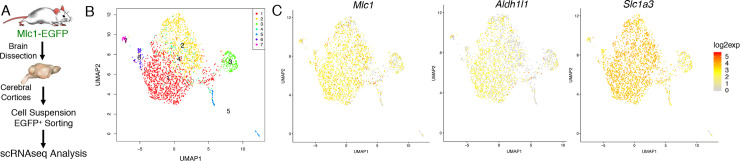
Analysis of gene expression in PAs isolated from the cerebral cortices of adult Mlc1-EGFP mice.(A); Schematic summarizing the experimental strategies for isolating cells from cerebral cortices of adult (P30) Mlc1-EGFP knock-in mice. Brain tissue was dissociated and live PAs were fractionated based on EGFP expression using FACS-based approaches. Single cells were subsequently analyzed using quantitative RNA sequencing. (B); Unsupervised clustering of single cell RNA sequencing data using EGFP-expressing PA cells fractionated from mouse cerebral cortices. Cells are clustered based on shared similarities in mRNA expression, with each of the two main clusters representing a subpopulation of PAs showing differential, but somewhat overlapping gene expression. (C); Feature plots showing the expression of select genes with established roles in mouse brain astrocytes including Mlc1 Aldh1l1, and Slc1a3. Each dot indicates a distinct mRNA sequencing result from a single cell. Red indicates higher gene expression and grey indicates lower gene expression.